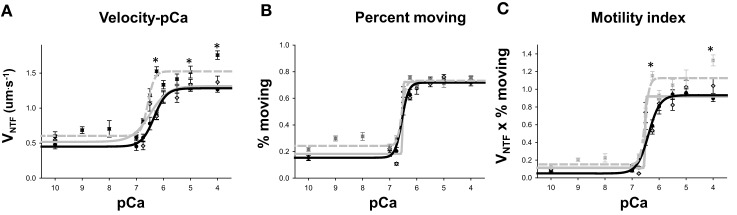
Velocity-pCa data. (A) Native thin filament velocity (VNTF) plotted as a function of free [Ca++] in –log units (pCa). Thin filaments from Control tissue are plotted with filled black dots and solid line, IR2 thin filaments with gray diamonds and solid gray line and the filaments from IDNR are plotted with dark gray boxes and a dashed gray line. Points represent mean ± SEM and the data were fit with the Hill equation (see Methods). * Indicates significantly (p < 0.05) different from WT VNTF. (B) Percentage of native thin filaments moving as a function of free [Ca++] symbols and lines same as in (A). (C) Motility index, defined as the product of VNTF and percent moving plotted as a function of free [Ca++]. One animal myocardium was used for each condition. The data represent the average actin filament velocities from between 3 and 20 to 30 s videos at each pCa level and for each condition.